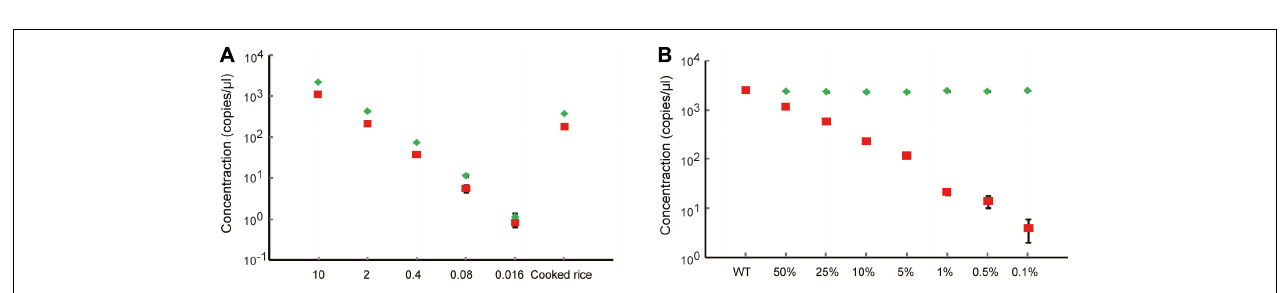
FIGURE 2 | Efficiently detecting different kinds of mutations used dPCR. (A) The target sequences of different mutant rice lines. The box and red line indicate the PAM and FAM-labeled probe, respectively. (B) The total number of events displayed using software to correct for Poisson distribution. Blue bars represent FAM-positive events, and green bars show HEX-positive events. (C) The combined droplet plots of different kinds of mutant gene-edited rice lines.